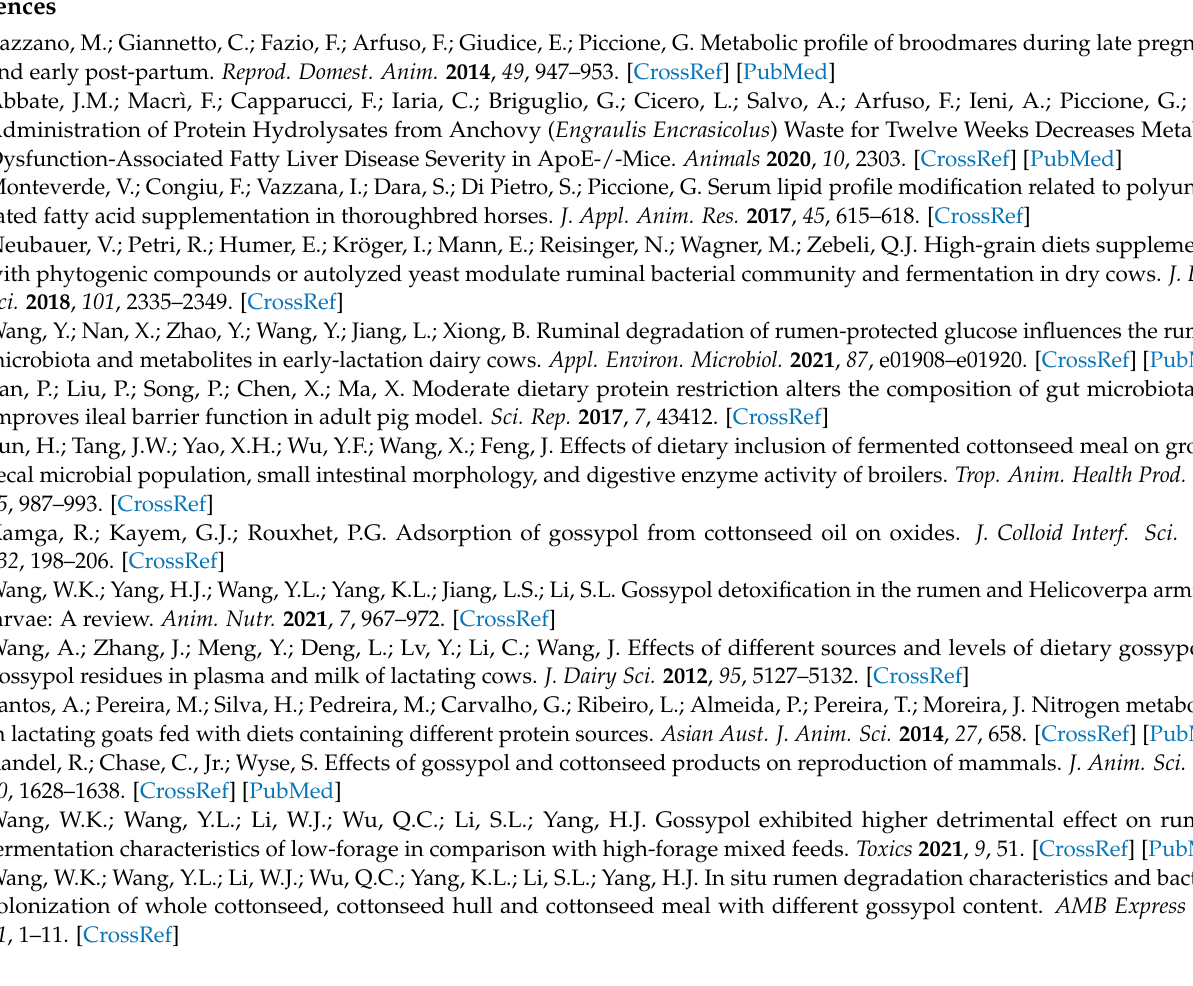
Table S1: The sequencing data information of